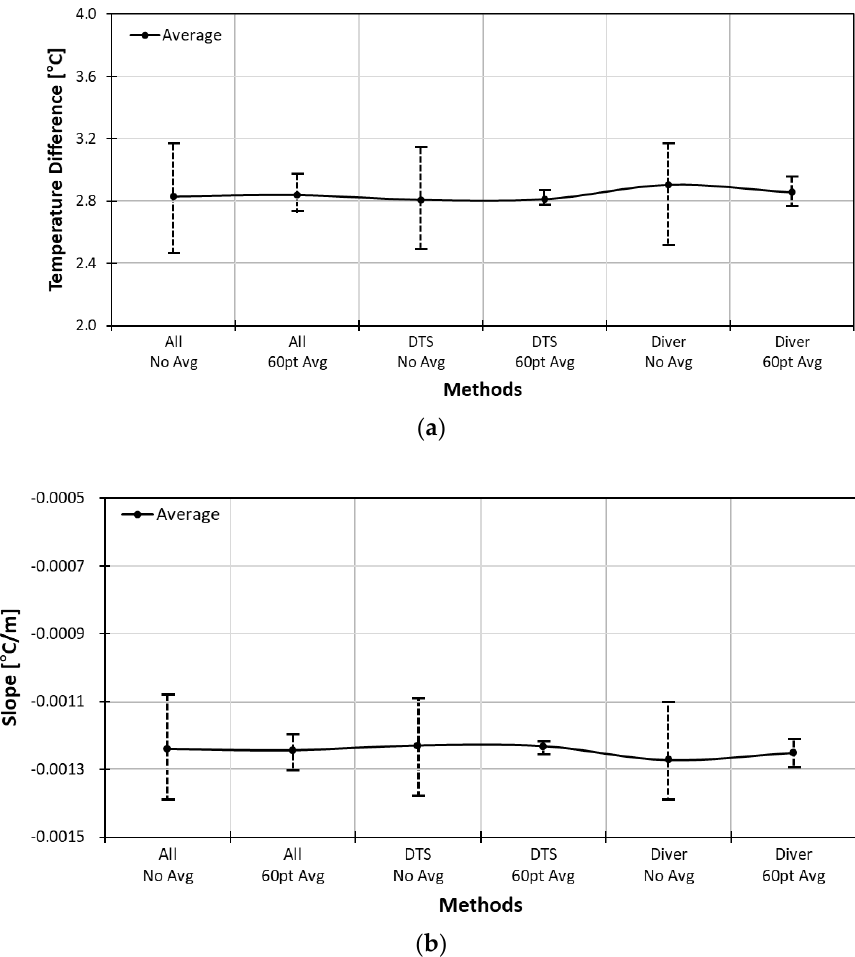
Figure 8. Comparison of long point water tub methods in terms of temperature difference ( a ) and slope range ( b ).